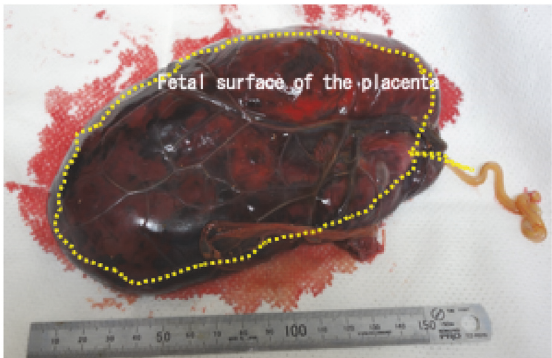
Figure 2: A subchorionic blood clot measuring 12 cm × 5 cm coveredalargeportionoftheplacentaandhadwell-definedmargins on the fetal surface (shown by dotted